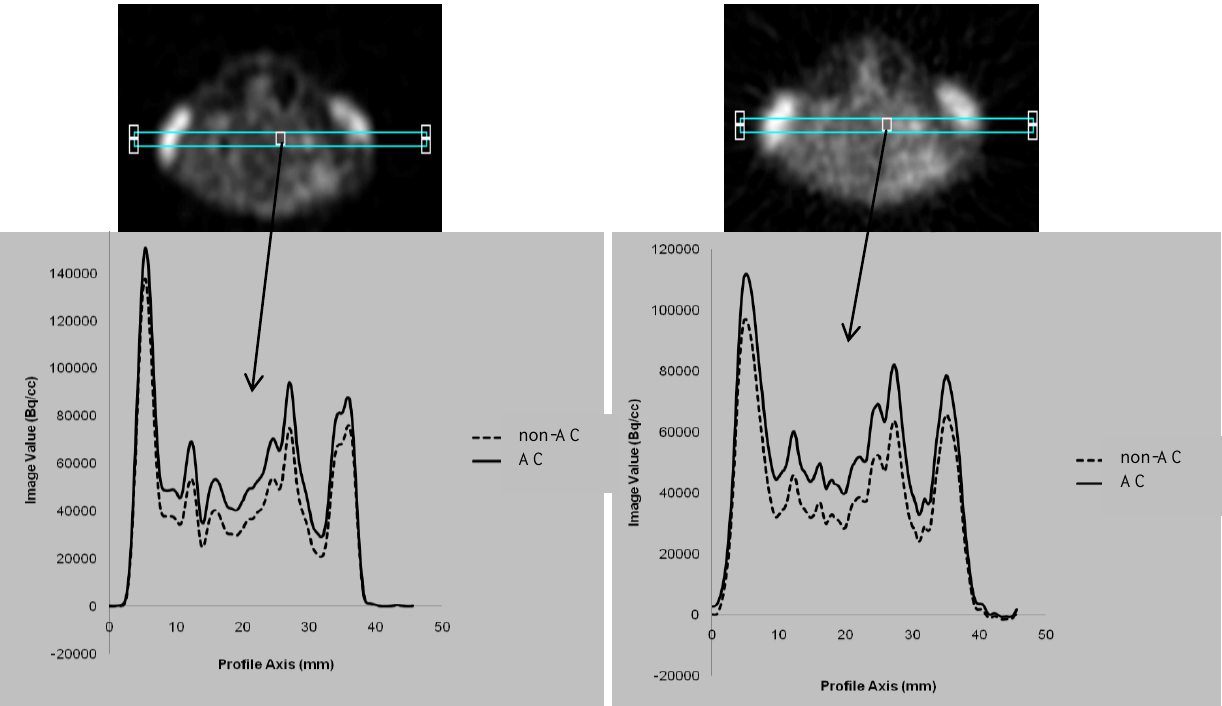
Figure 1. The profiles of MAP- and FBP-reconstructed images through the transaxial images are shown. The CT based attenuation correction was used. The profiles revealed that the emission images of the small animals such as mice are indeed affected by